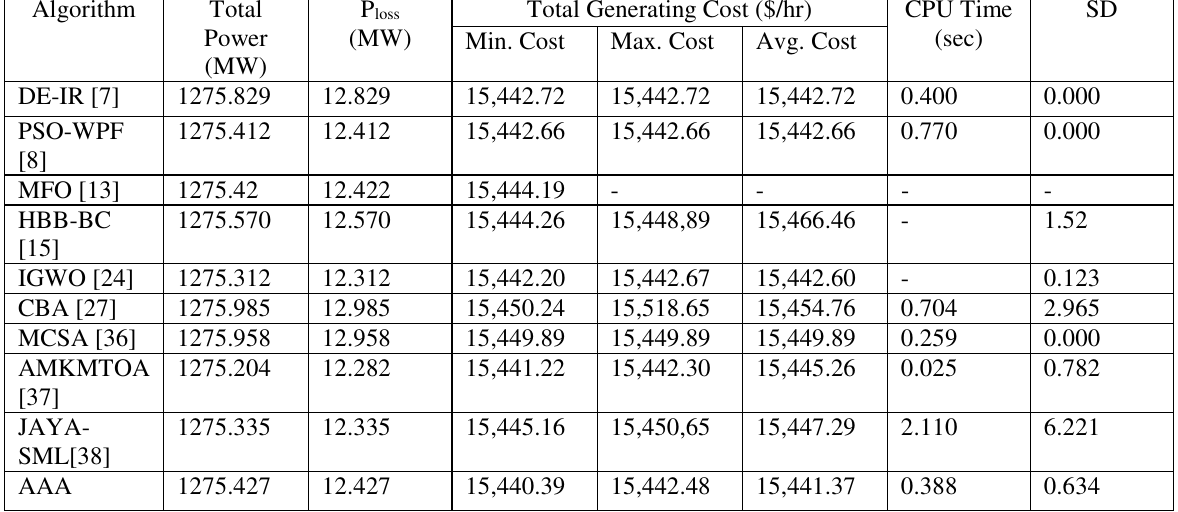
TABLE 2: COMPARISON OF RESULTS FOR TEST CASE 2 Algorithm